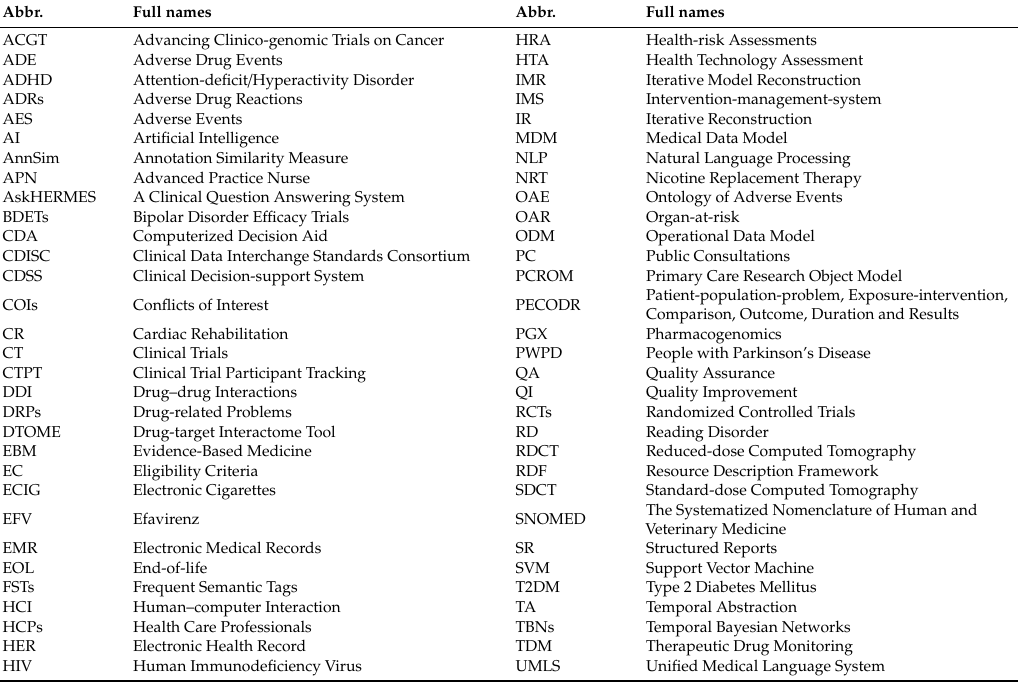
Table A3. Full names of the abbreviations (in capitals) in Table 10.